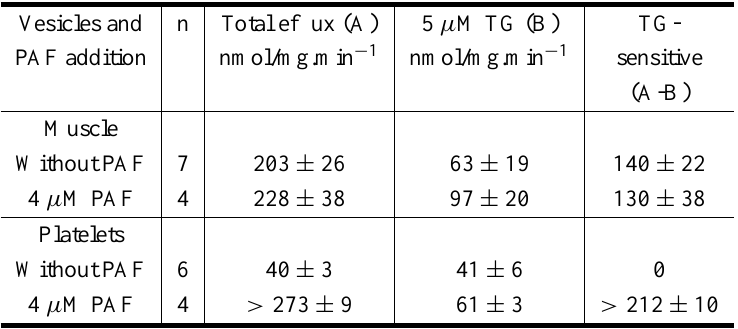
Ca 2 + efflux from skeletal muscle and blood platelets vesicles.